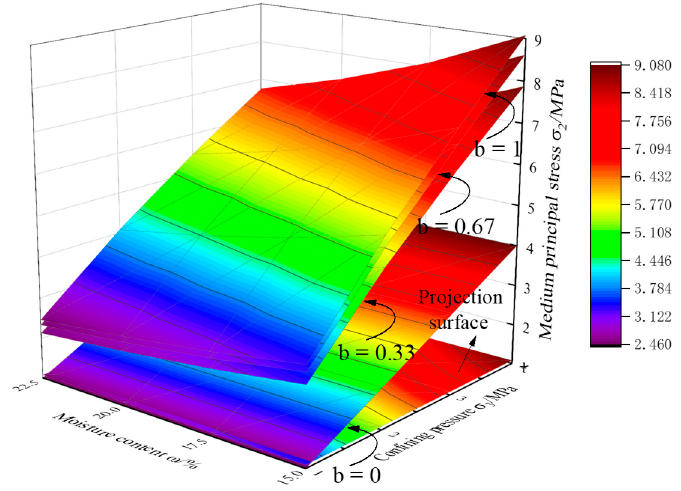
Figure 7. Three-dimensional trend chart of confining pressure, water content, and intermediate principal stress under different b values.